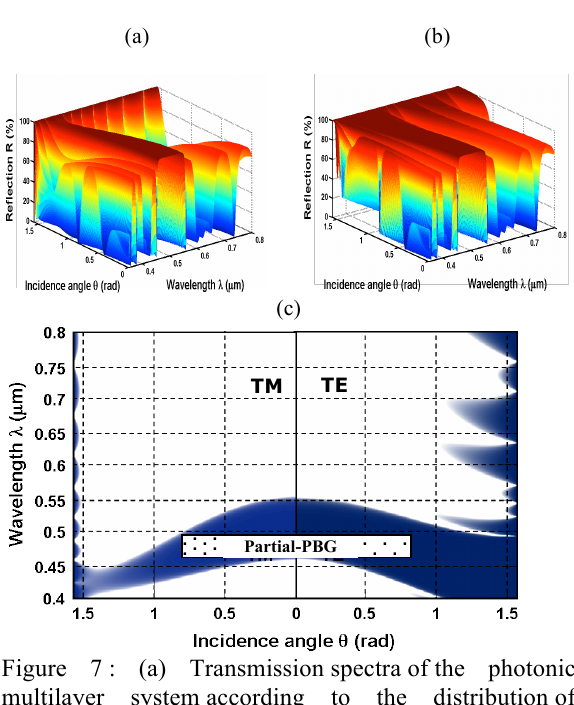
Figure 6 : (a) Transmission spectra of the photonic multilayer system according to the distribution of Thue-Morse for the 5th generation TM(5), mode TM. (b) Transmission spectra of the photonic multilayer system according to the distribution of Thue-Morse for the 5th generation TM(5), mode TE. (c) Photonic band structures for the TM(5), where R > 99.9 %.